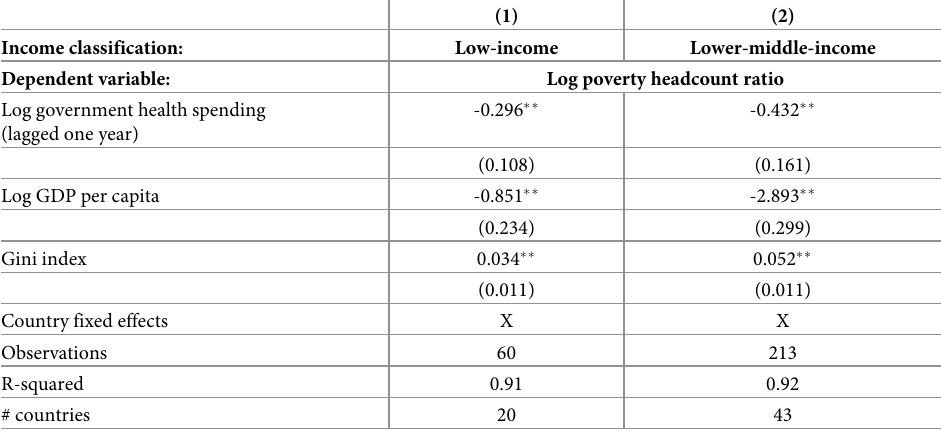
Table 3. Estimating the association between government health spending and poverty alleviation—differences across income groupings. Income classification: